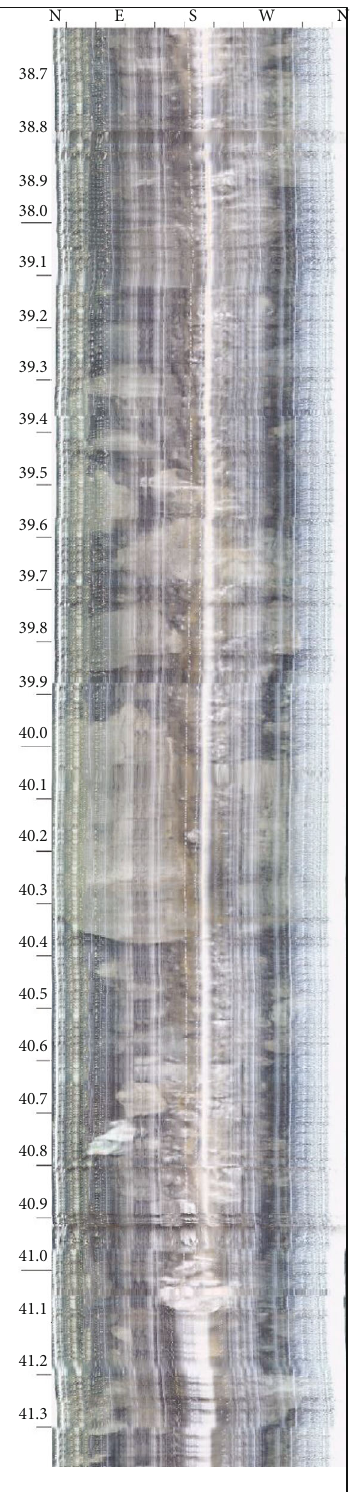
Figure 4: Television image of the interface between KCC surrounding rock and KCC body.